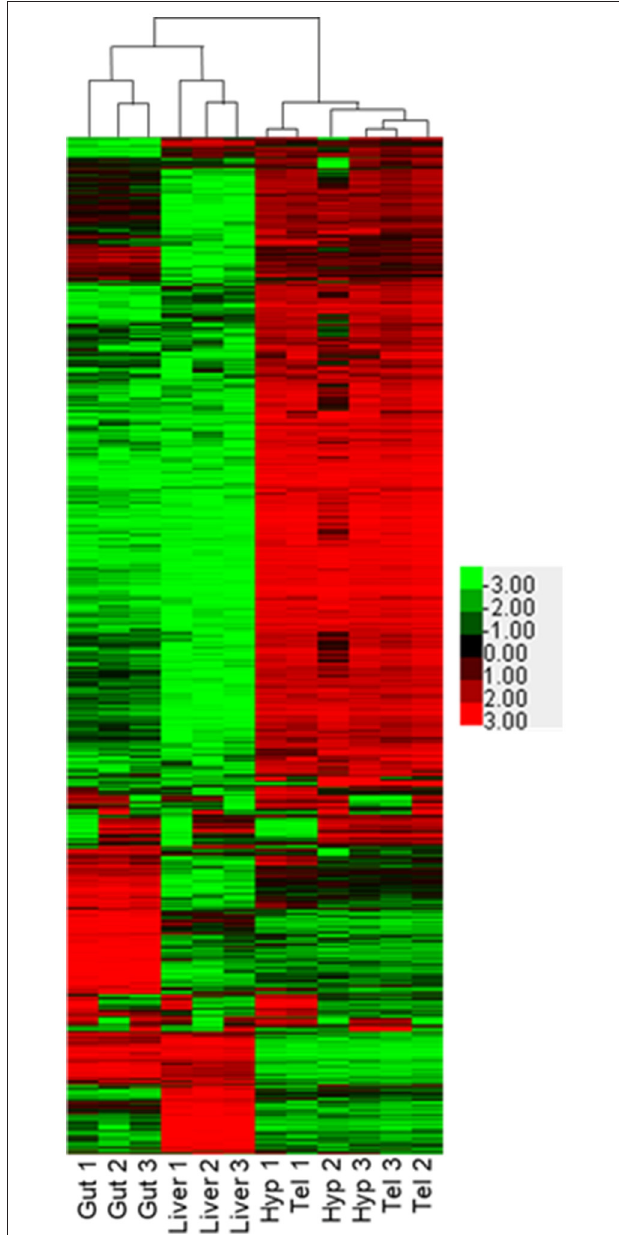
FIGURE 3 | Comparison of transcriptional profiles for gut, liver, hypothalamus, and telencephalon. Heat map depicts Log2 (FPKM) of transcripts identified with at least 50 counts in at least three samples and a Max Value-Min Value > 5. Hierarchical clustering was performed using Cluster 3.0 and visualized using Java